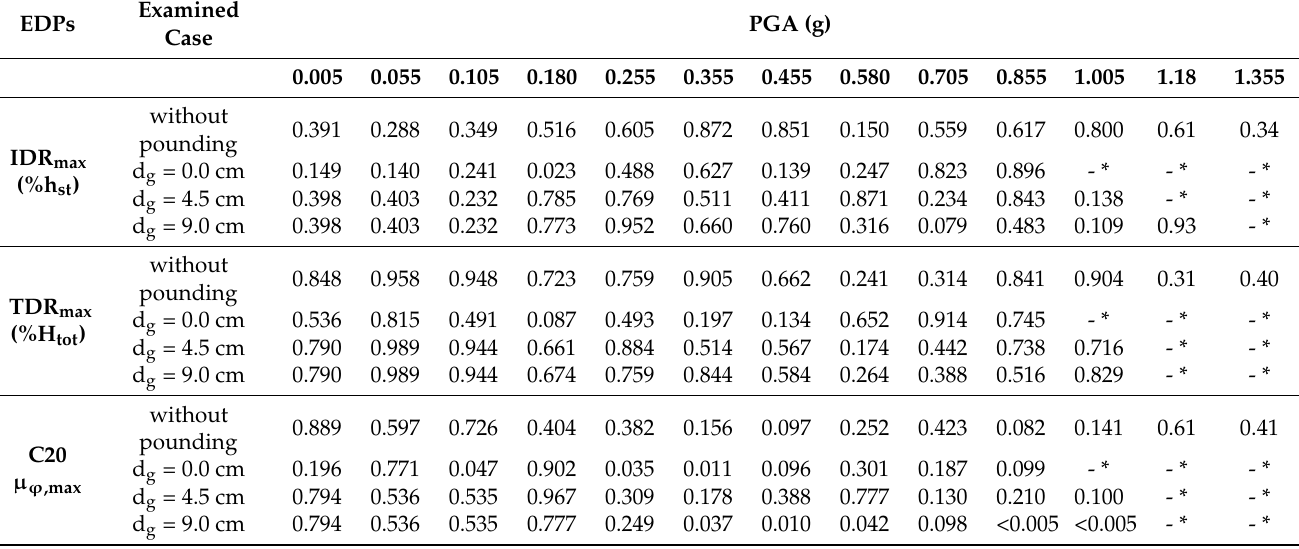
Table 3. Check of the lognormality assumption ( p -value cut off equal to